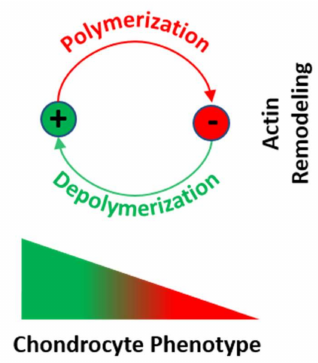
Figure 13. Relationship of the balance of actin polymerization and depolymerization with chon- drocyte phenotype. Increased actin polymerization is associated with inducing a dedifferentiated, fibrogenic phenotype (red; indicated with by the “-“ symbol), whereas actin depolymerization is associated with regaining a chondrogenic phenotype (green; indicated with the “+”